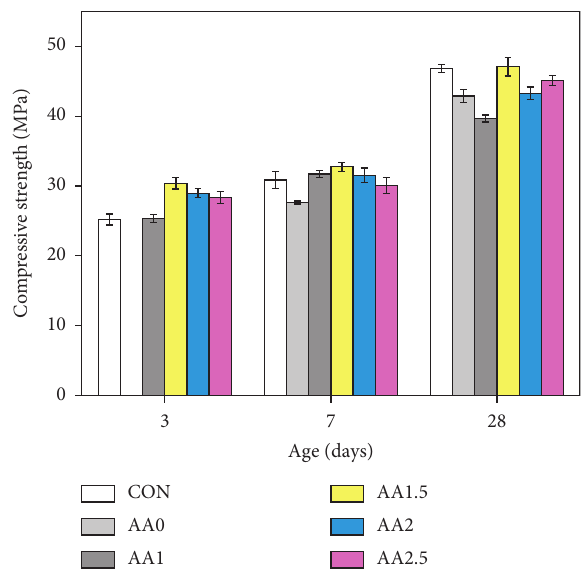
Figure 6: Compressive strength of test blocks at different ages.